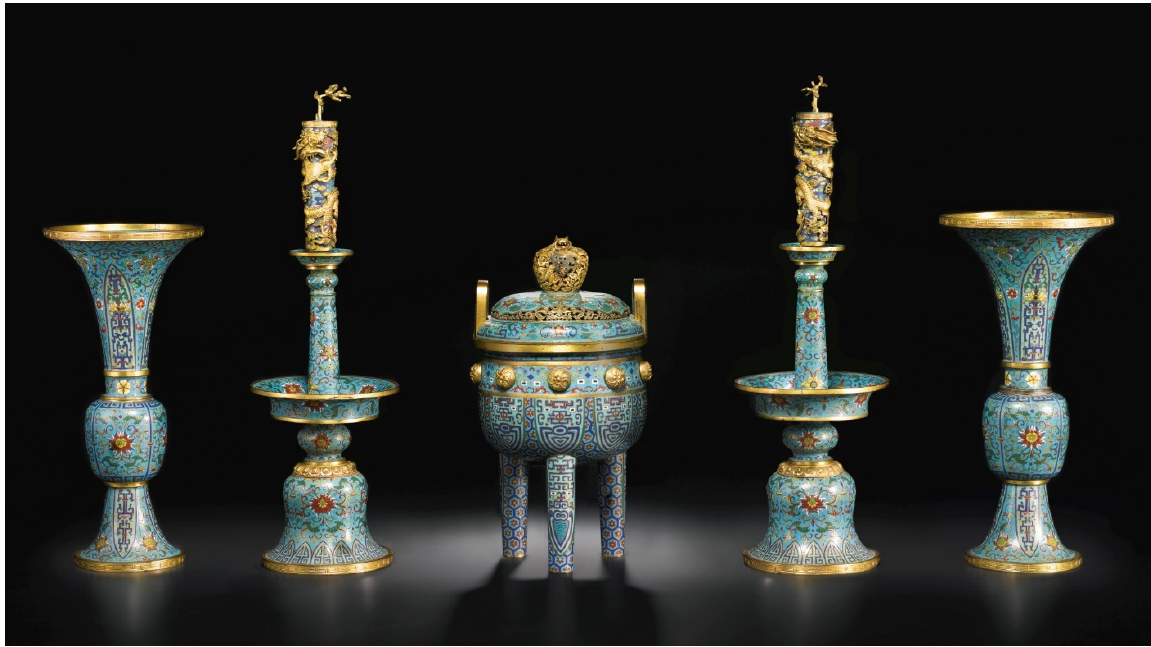
Figure 11. Five-piece altar garniture, or wugong , Qianlong period (r. 1735–1796), China. Formerly at the Caramoor Center for Music and the Arts. Photo: Sotheby’s.